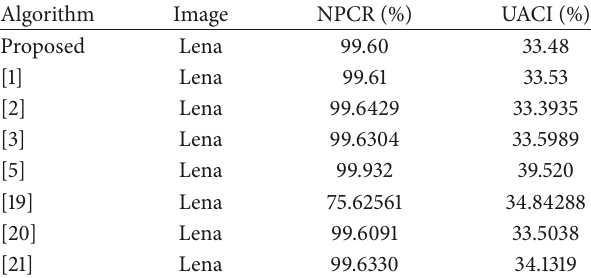
Table 16: Comparison of NPCR and UACI of